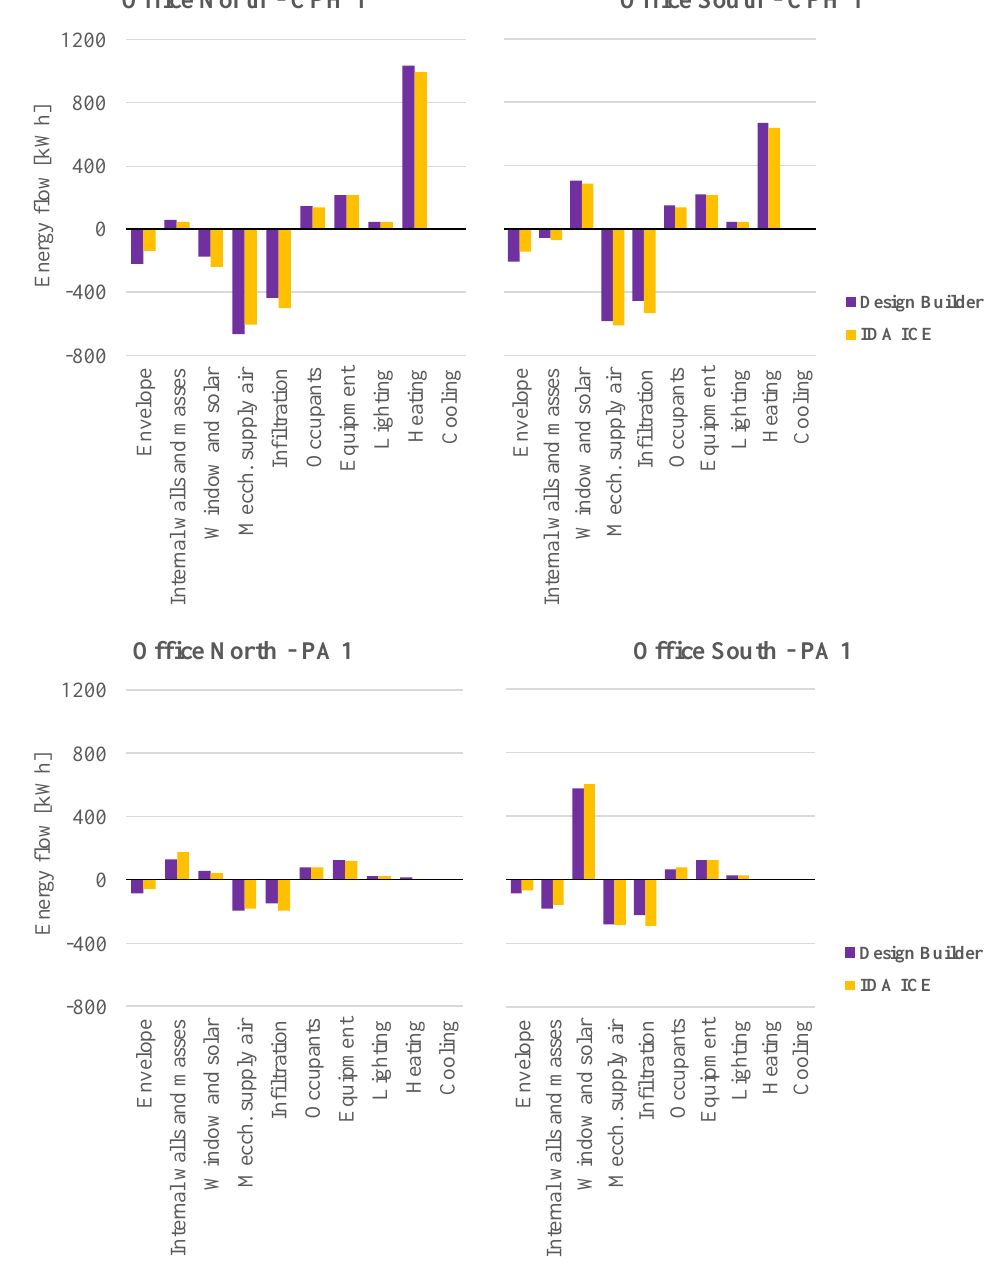
Figure 7. Energy flows for Copenhagen (up) and Palermo (down) in scenario 1 during the heating season.